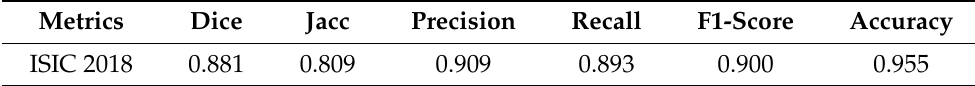
Table 1. Experimental results on the ISIC 2018 dataset.